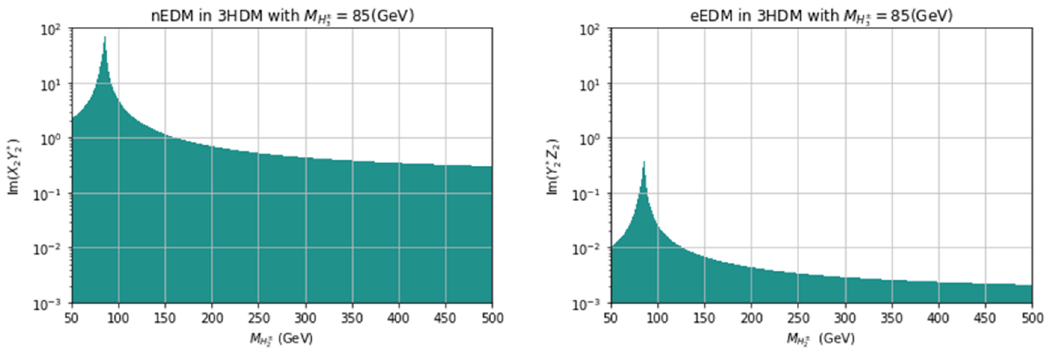
Figure 10 . Constraint from the nEDM (left) and the eEDM (right) on | Im( X 2 Y ∗ in the 3HDM as a function of the mass of H +